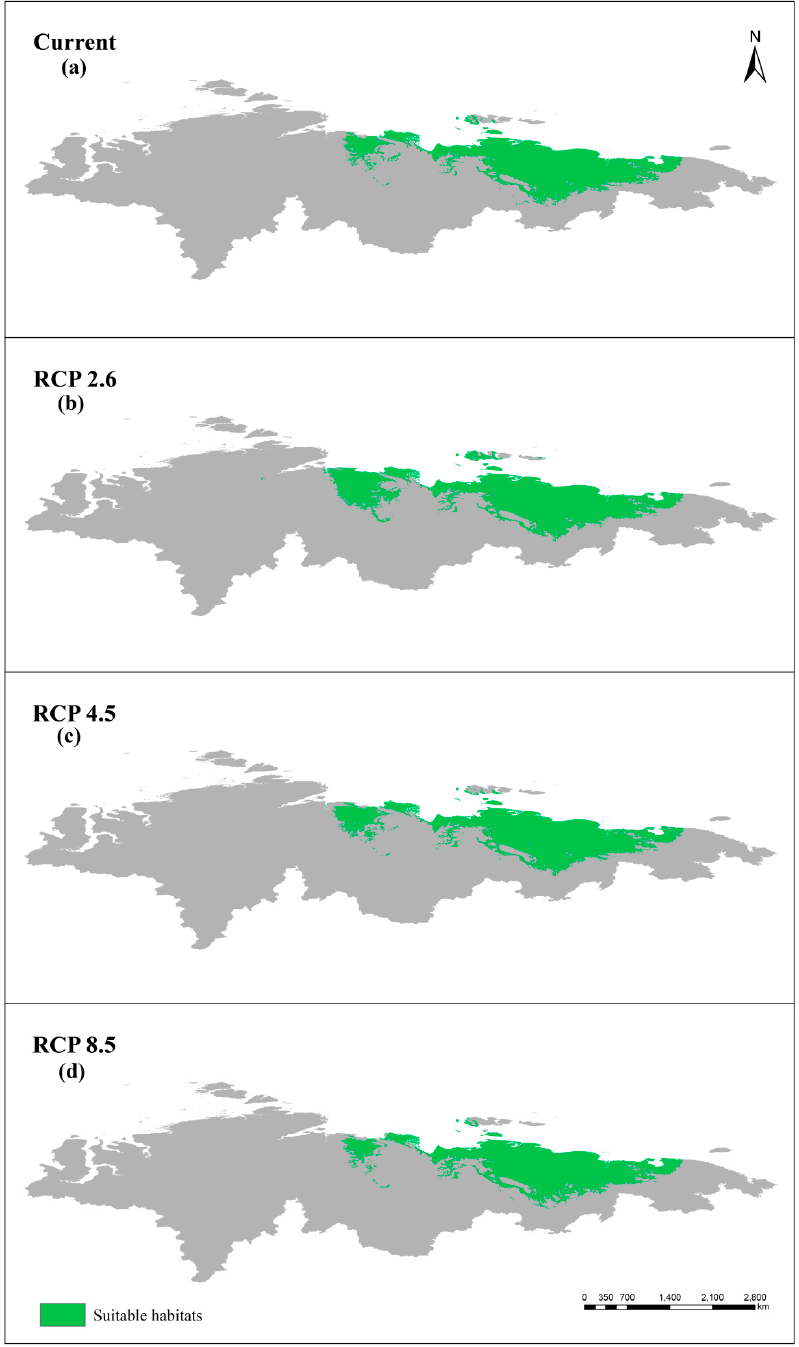
Figure 3. Distribution of appropriate habitat and breeding sites for lesser white-fronted goose in 2050 under ( a ) current conditions, ( b ) RCP2.6, ( c ) RCP4.5, and ( d ) RCP8.5.